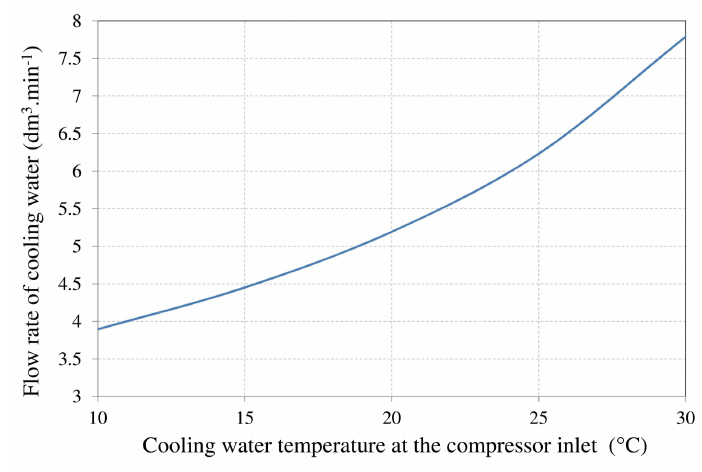
Figure 17. Recommended minimum cooling water flow rate, depending on the inlet water temperature.